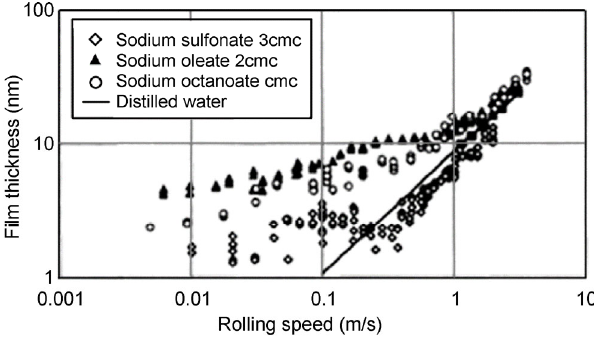
Fig. 23 Film formations of aqueous surfactant solutions presented by Ratoi and Spikes [109]. Copyright 1999, Taylor &